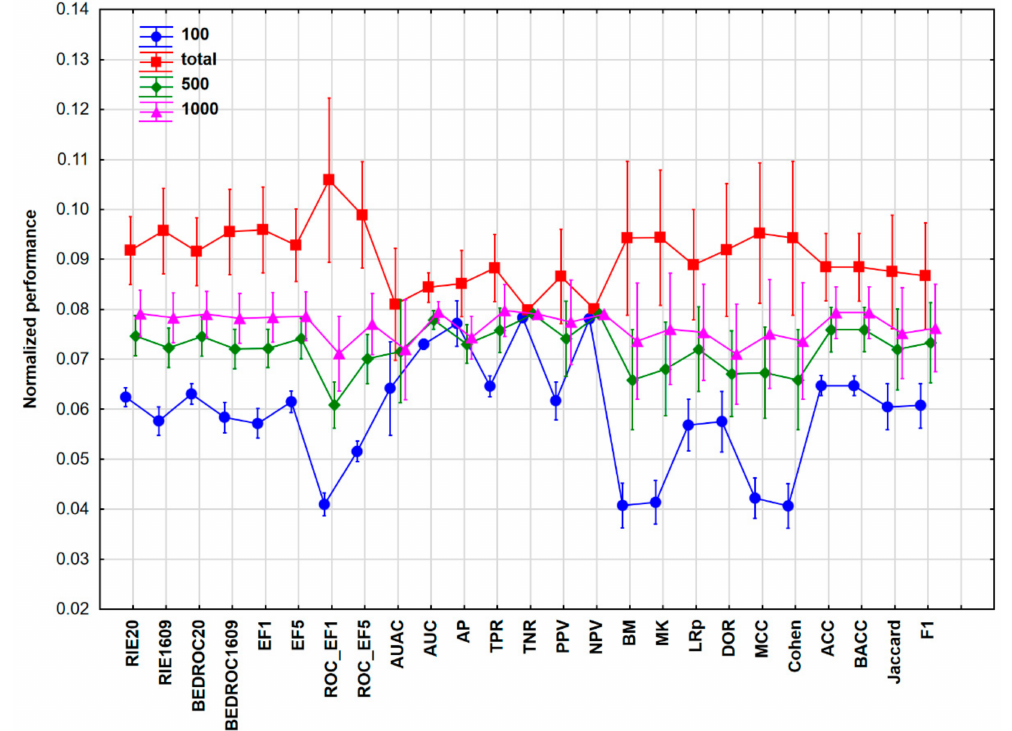
Figure 4. The average normalized values of the different performance parameters with the 95% confidence intervals for Case Study 2. Normalization of performance parameters was necessary to be comparable. Number of samples (NS) is 100 (blue circles), 500 (green diamonds), 1000 (purple triangles), or total (1542, red squares).